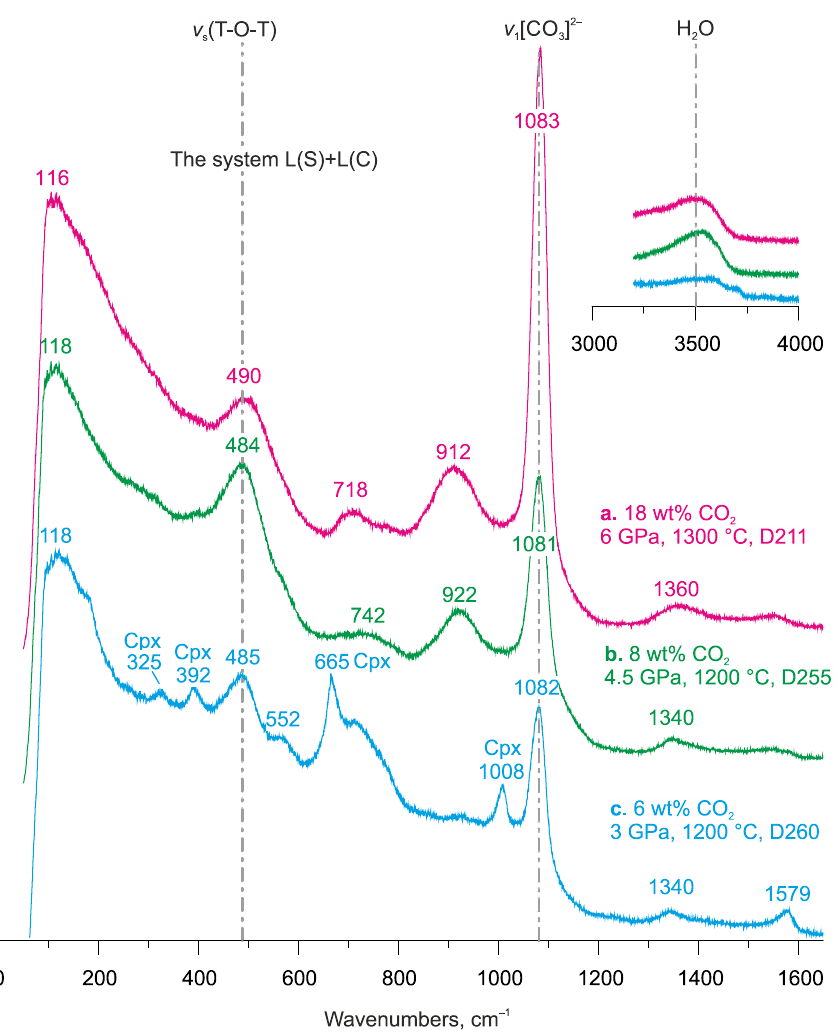
Figure 16. Representative Raman spectra of silicate glass in the system L(S)+L(C). ( a ) run D211 at 6 GPa and 1300 °C, ( b ) run D255 at 4.5 GPa and 1200 °C, and ( c ) run D260 at 3 GPa and 1200 °C.